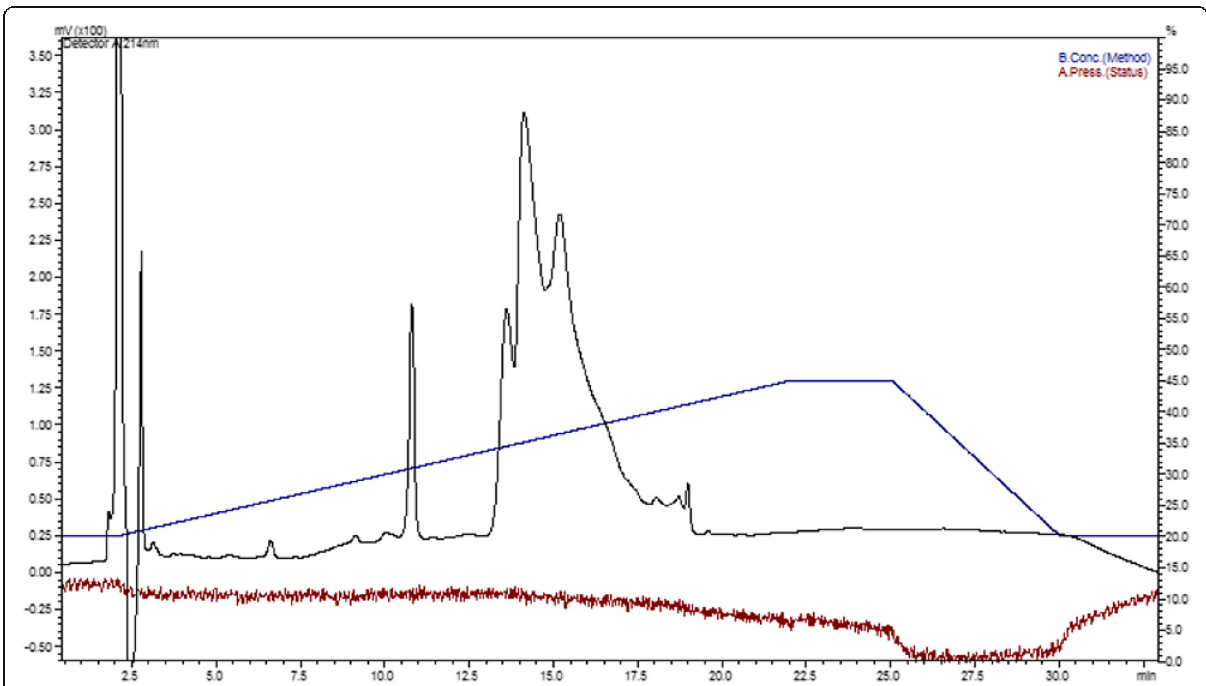
Fig. 2 Reverse phase chromatogram of peak nine. Elution was performed with a gradient of B solution (90% acetonitrile/0.1% TFA/water) ranging from 20 to 50%, in 20 min, at a flow rate of 1